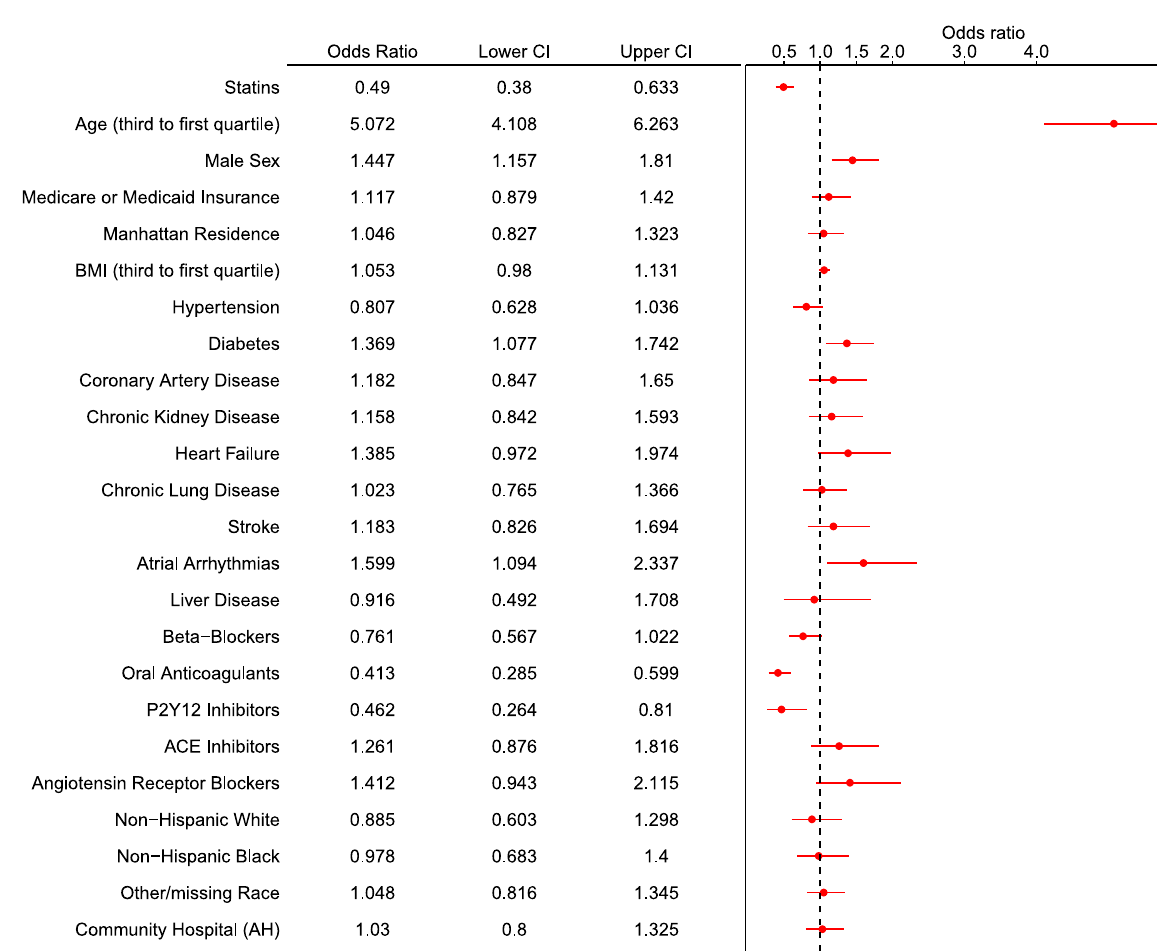
Fig. 1 Forest plot for in-hospital mortality within 30 days. Forest plot demonstrating the odds ratio (OR) and 95% con fi dence interval (CI) for in-hospital mortality within 30 days with antecedent statin use (vs. no antecedent statin use) after multivariable logistic regression in the overall cohort. A number of other sociodemographic and baseline medication variables are also presented in this forest plot. ACE angiotensin-converting enzyme; AH Allen hospital. N = 2626 biologically independent